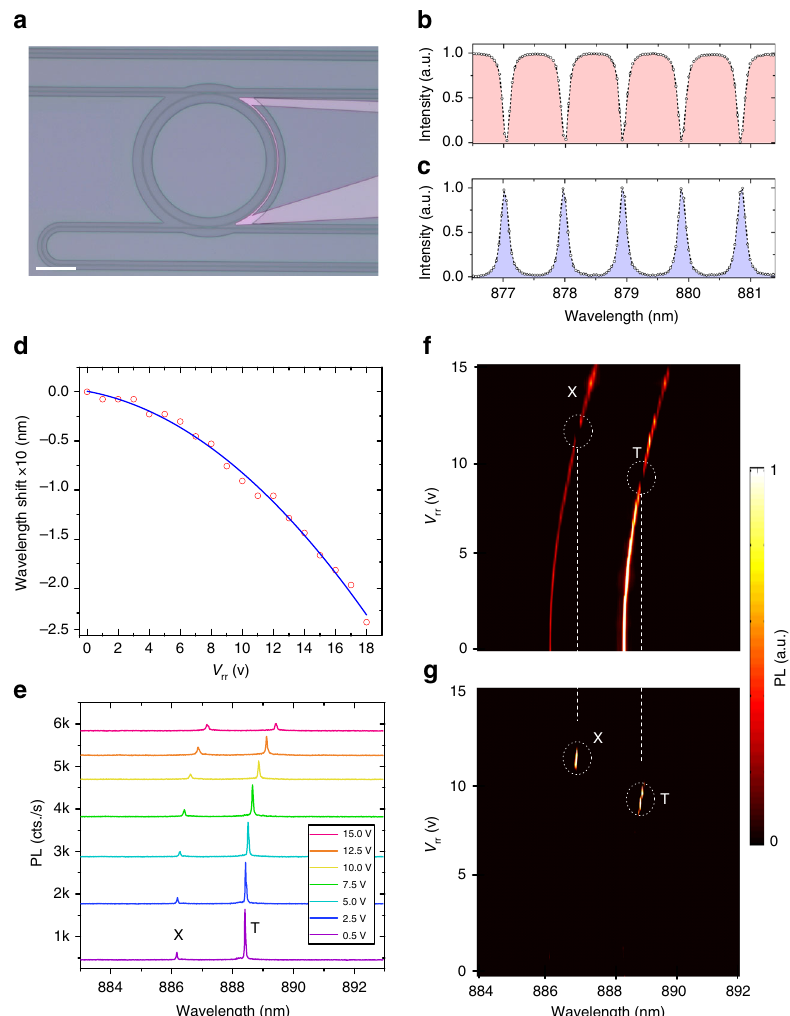
Fig. 2 On-chip single-photon routing. a A microscope image of the ring resonator fi lter. The fi lter transmission is controlled with a titanium resistor, the scale bar has length of 70 µ m. Details of the fabrication process are provided in the Methods section. Graphs b and c show the through-port and drop-port transmission of the ring resonator, respectively. d Tuning of the ring resonator fi lter as a function of the fi lter voltage ( V rr ).The red circles show the measured shifts while the blue line is a fi t. The resonances are blue shifted by design, which is achieved by means of the large negative thermo-optic coef fi cient of the PMMA top cladding. e Tuning of the QD transition as a function of the ring resonator voltage. In contrast to the observed shift for the ring resonator, the QD emission red shifts for increasing voltage as expected due to the increase in temperature. Graphs f and g show the results of selectively routing a unique transition of the QD between the drop-port and through-port of the ring resonator. As we tune the fi lter resonance using the integrated heater, a single emission line can be tuned in and out of resonance, thus routing single photons between the through-port and